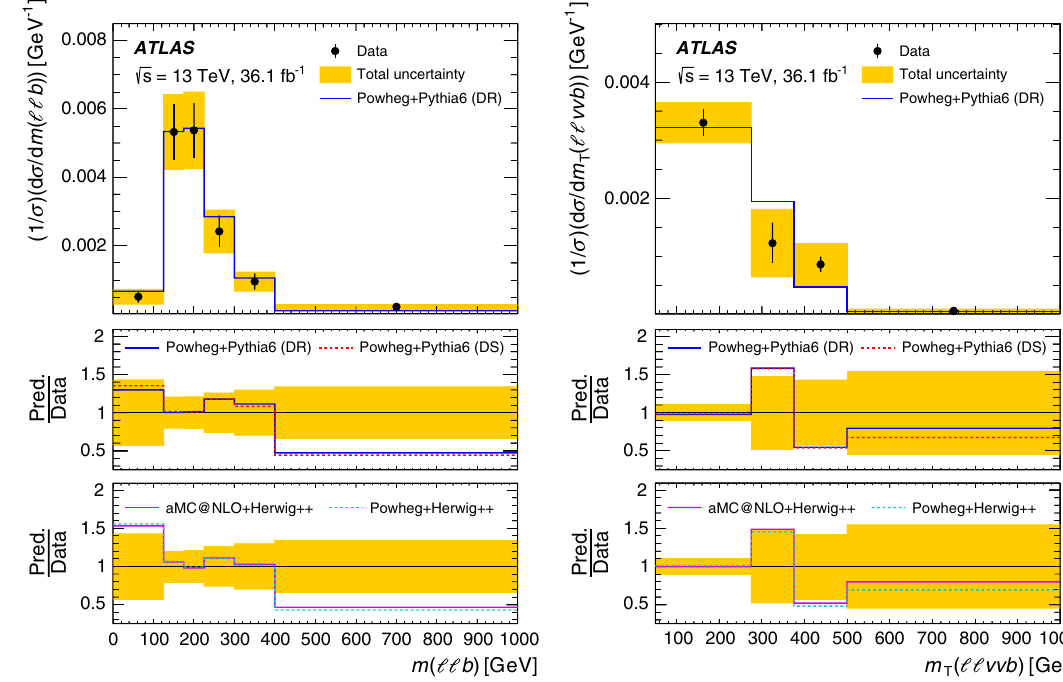
Fig. 6 Normalised differential cross-sections unfolded from data, compared with selected MC models, with respect to m T ((cid:6)(cid:6)νν b ) and m ((cid:6)(cid:6) b ) . Data points are placed at the horizontal centre of each bin. See Sect. 1 for a description of the observables plotted